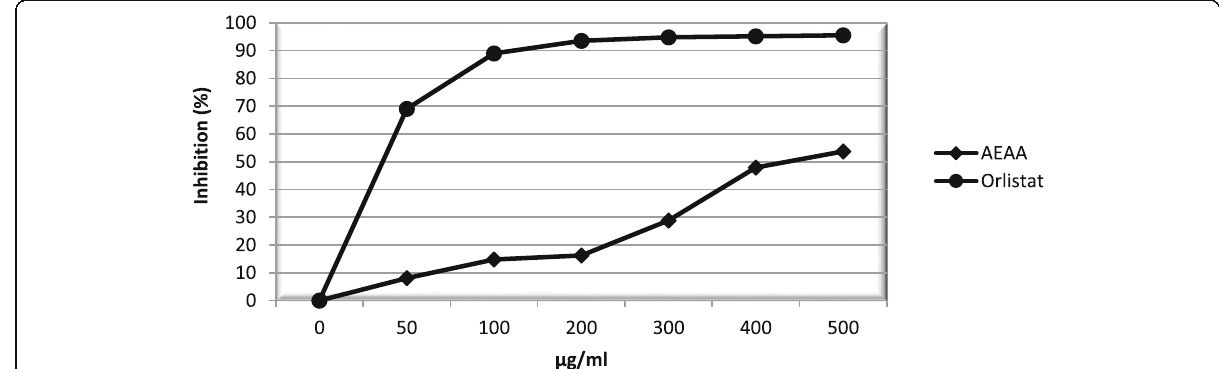
Fig. 2 The inhibitory effect of AEAA on Pancreatic Lipase activity; values are mean of 4 experiments; AEAA – Aqueous Extract of Achyranthes aspera